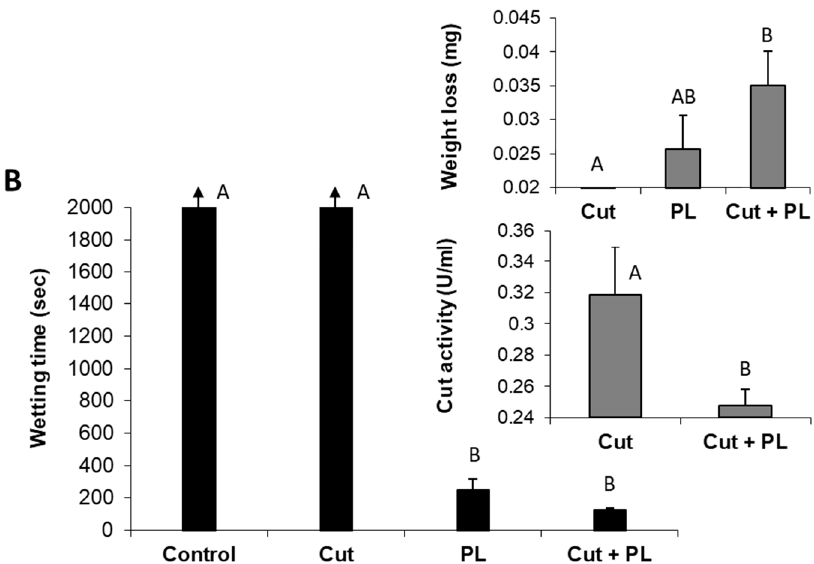
Figure 7. Scouring of cotton fabrics with a combination of cutinase and pectin lyase. ( A ). Effect of enzymatic scouring (with a relatively high dose of cutinase) on cotton fabrics’ water absorbency and the release of hydrolysis products. Changes in the reaction solution chloroform extract detected by ELSD-RP HPLC. Cut: cutinase alone; PL: pectin lyase alone; Cut + PL: a combination of the two enzymes. Incubations of the fabric swatches and the enzymes were carried out for 24 h in a rotary shaker (175 rpm) at 37 ◦ C and pH 8 (100 mM phosphate buffer) with 80 U/mL Cut and 200 U/mL PL, or their mixture, in the absence of detergent. ( B ). Effect of enzymatic scouring (with a relatively low dose of cutinase) on cotton fabrics water absorbency, Cut residual activity, the fabrics’ weight loss, and release of hydrolysis products. Incubations of the fabric swatches and enzymes were carried out for 4 h in a rotary shaker (175 rpm) at 37 ◦ C and pH 8 (100 mM phosphate buffer) with 1.7 U/mL Cut and 301 U/mL PL, or their mixture, in the absence of detergent. Values represent an average of three independent replicates. Arrows represent wettability values above 2300 s (A) or 5400 s (B)—the experiment discontinuance. Bars indicate standard error.